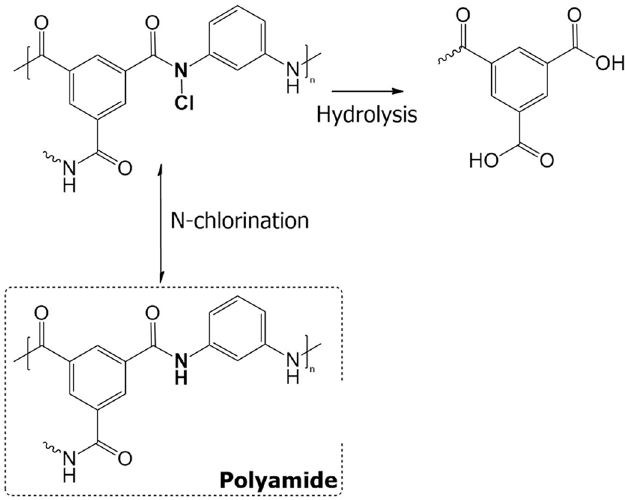
Figure 5. Mechanism of chlorine attack under alkaline conditions with low concentrations of chlorine. Adapted from Verbeke et al. [42].